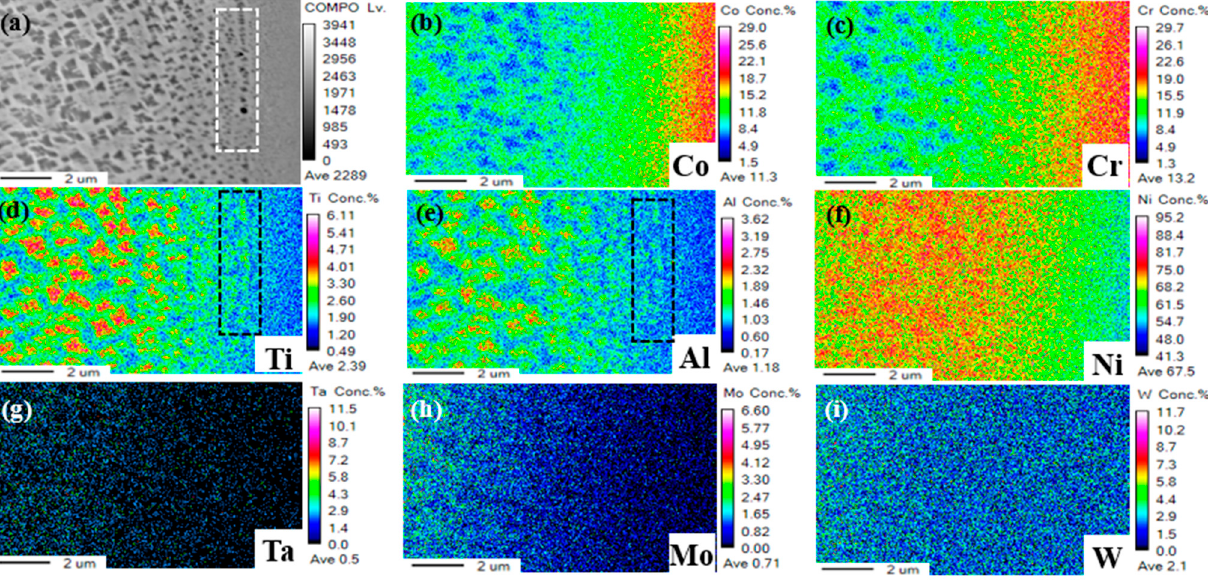
Figure 3. The EPMA results of joints bonded by 1150 °C with the corresponding elements distribution map showing ( a ) test location, ( b ) Co, ( c ) Cr, ( d ) Ti, ( e ) Al, ( f ) Ni, ( g ) Ta, ( h ) Mo and ( i ) W.